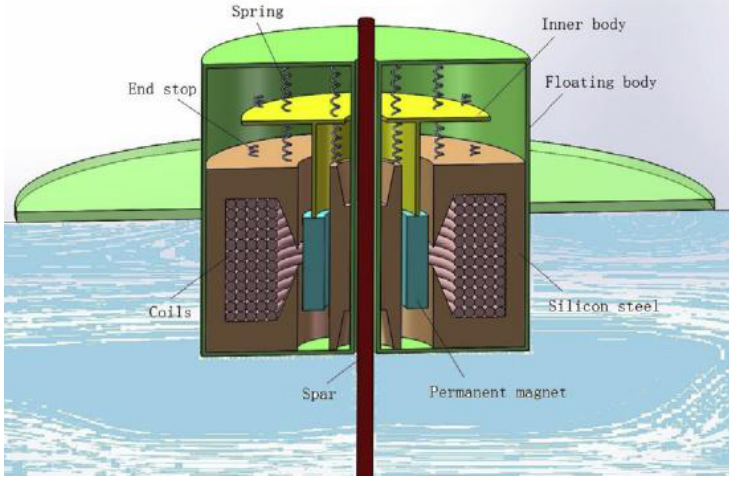
Figure 15. A two-body WEC with both bodies floating, and a linear PTO sealed in between [95] .